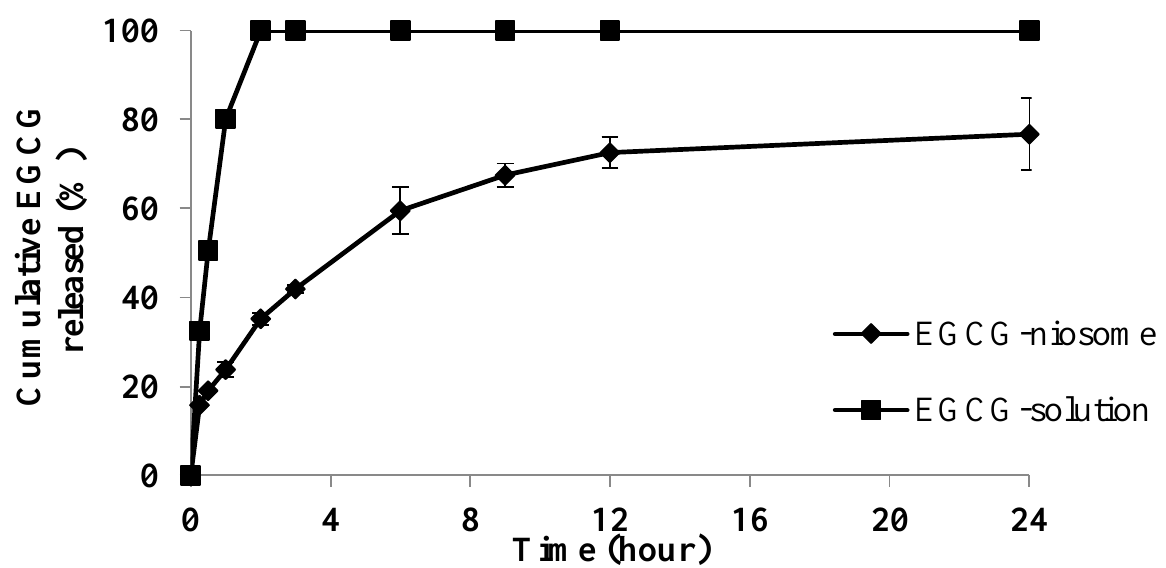
Figure 4. In vitro drug release of EGCG-niosomes and EGCG solution (mean ± SD, n = 3). Table 9. Drug release kinetic parameters of EGCG niosomes. Formulation